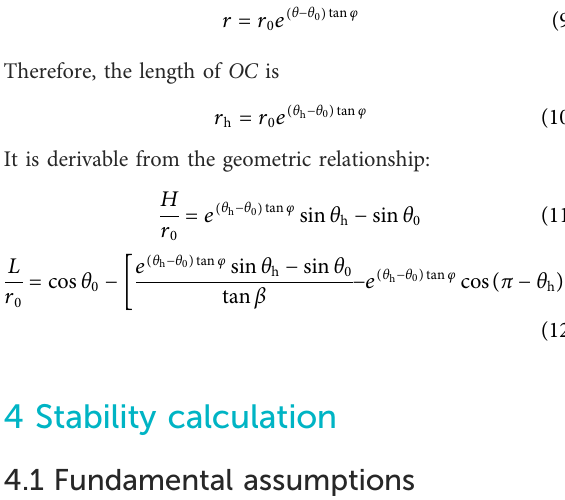
TABLE 1 c and φ under the uni fi ed strength